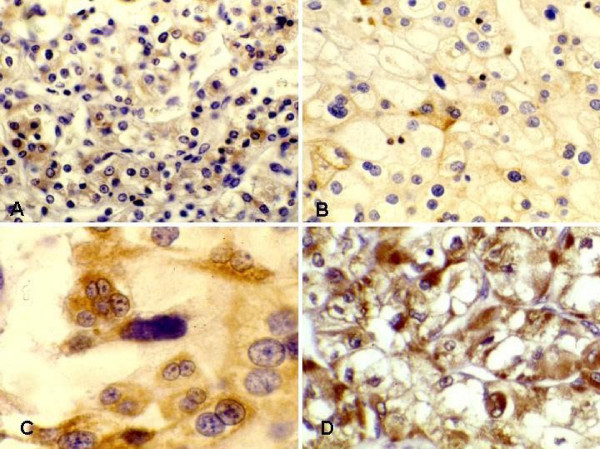
Immunohistochemical MDR-1 expression in RCCs. Representative examples of RCCs with low (A: ×100; B: ×250) and high (C: ×400; D: ×400) MDR-1 expression, as evaluated by immunohistochemistry (LSAB-HRP, nuclear counterstaining with haematoxylin).